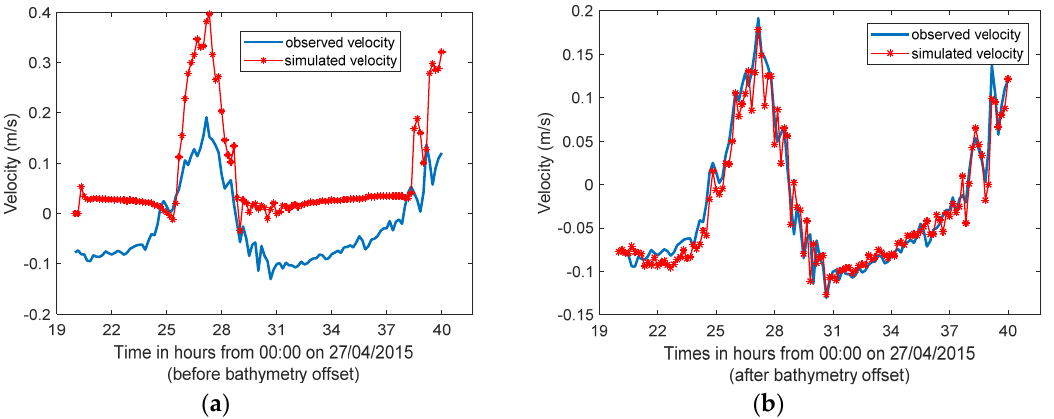
Figure 6. Observed vs. simulated velocities ( a ): before 1 m bathymetry offset and ( b ) after 1 m bathymetry offset.